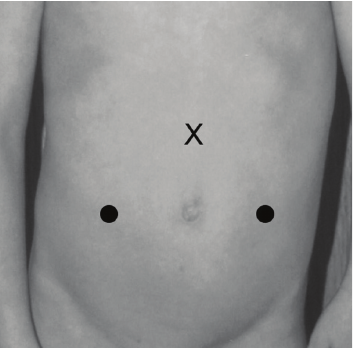
Figure 3: Port placement, small children or short-waisted children, bilateral reimplants.